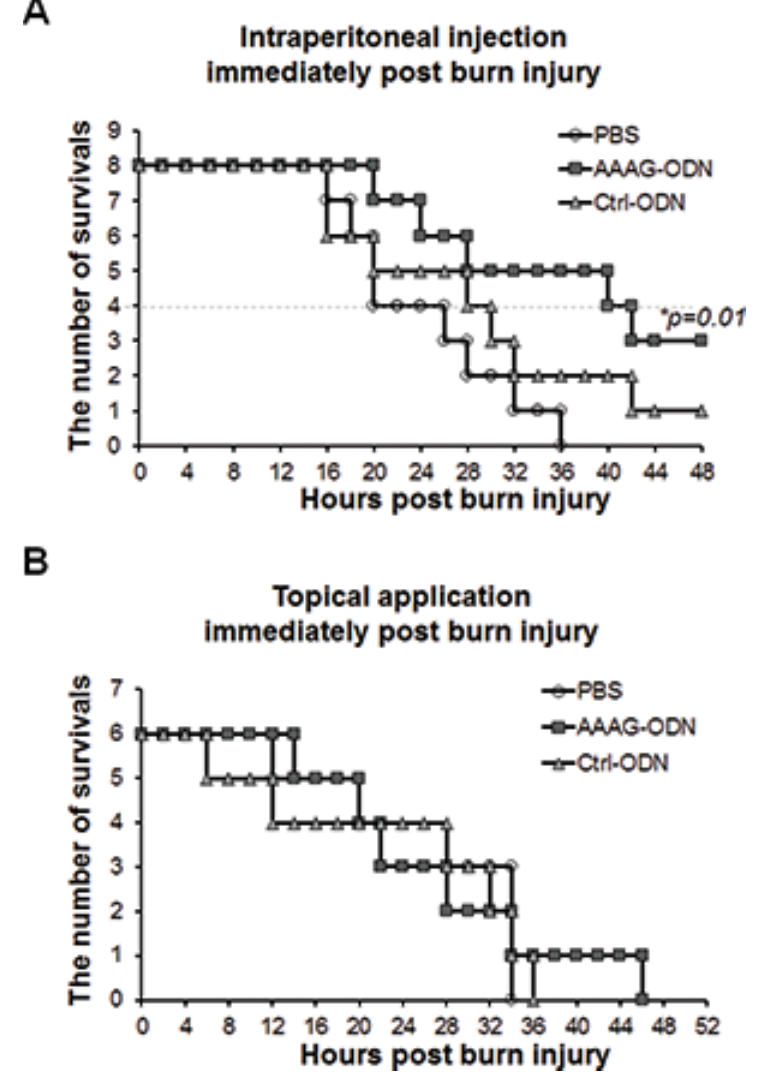
Figure 2. Effect of AAAG ODN on the survival of burn-injured mice. Burn-injured mice were treated with AAAG ODN or control ODN or PBS by (A) intraperitoneal or (B) topical application and their survival was